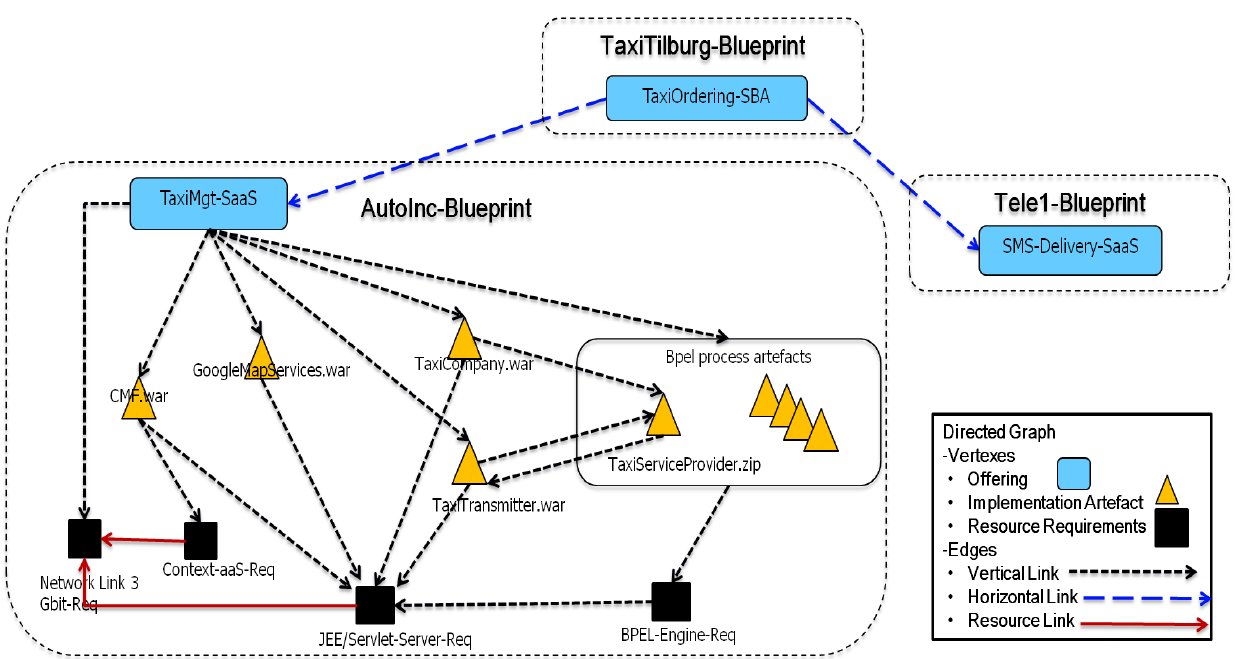
Figure 6. A sample Virtual Architecture (VA)